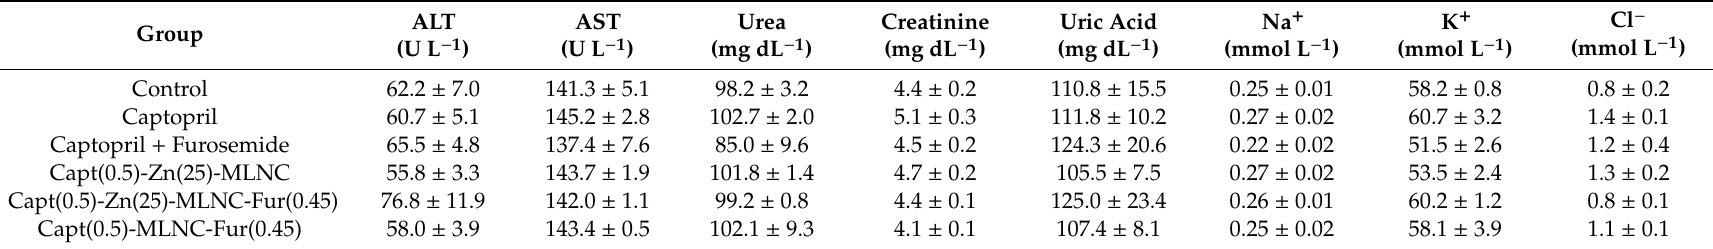
Table 2. Biochemical analyses in serum of spontaneously hypertensive rats (SHR) after 5 days of oral treatment (8 mL kg − 1 ) with solutions or formulations ( n = 6). Values are expressed as mean ± SEM. Data were analyzed by ANOVA.